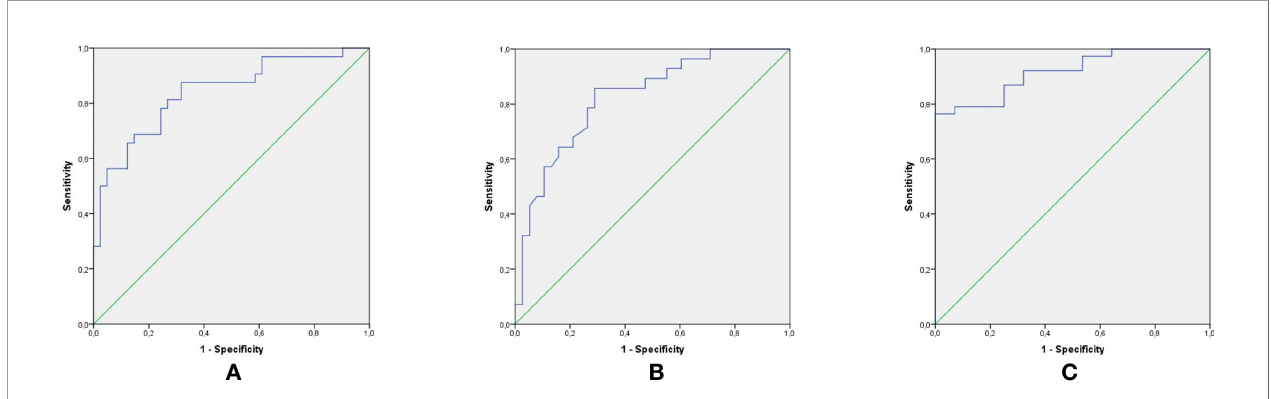
FIGURE 1 | Diagnostic value of serum BDNF and IGF-1 for MDD diagnosis. (A) ROC curve for BDNF to diagnose MDD (p < 0.0001, AUC: 0.840; sensitivity; 81% and speci fi city: 73% for a cutoff of < 763.17 pg/ml). (B) ROC curve for IGF-1 to diagnose MDD (p < 0.0001, AUC: 0.824; sensitivity; 84% and speci fi city: 64% for a cutoff of > 178.00 ng/ml). (C) ROC curve the combination of BDNF and IGF-1 to diagnose MDD (p < 0.0001, AUC: 0.916). AUC, Area Under the ROC Curve; BDNF, Brain-Derived Neurotrophic Factor; IGF-1, Insulin-Like Growth Factor; MDD, major depressive disorder; ROC, receiver-operating